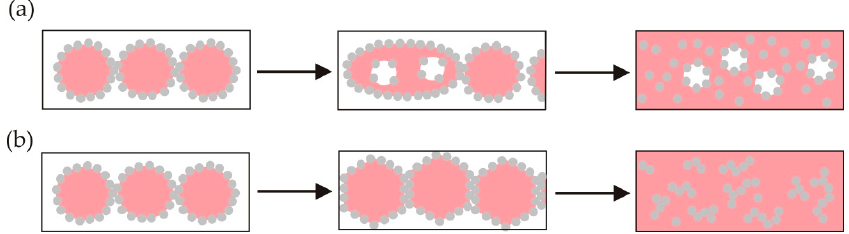
Figure 8 . Pickering emulsions destabilise and catastrophically phase invert in response to an increase in their drop volume fraction. ( a ) Inversion may occur via the incorporation of drops of the continuous phase into drops of the dispersed phase as they coalesce in emulsions that are being sheared. Further shearing, or increases of the drop volume fraction, result in inversion of the dispersed and continuous phases in the emulsion; ( b ) Evaporation of the continuous phase from an emulsion can increase the volume fraction of the drops above the maximum fraction at which they can closely pack without distortion. Further evaporation causes the drops to coalesce together into a continuous liquid film and the particles to become completely immersed in the